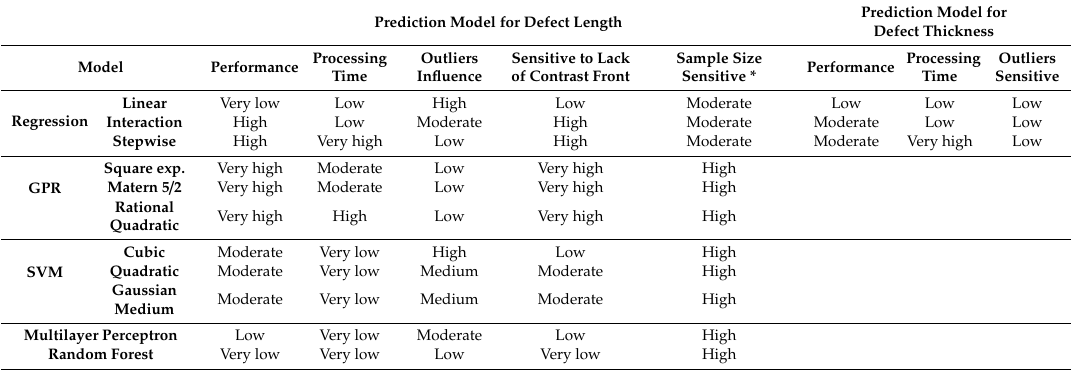
Table 10. Qualitative comparison of the predictive models based on results.